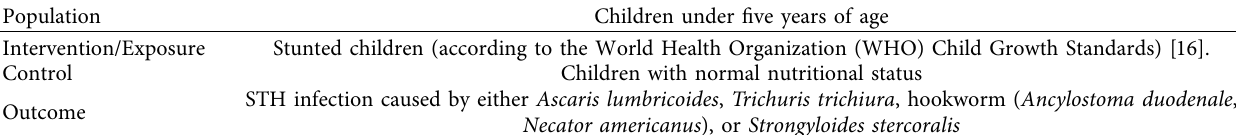
Table 1: The PICO method to define keywords for searching